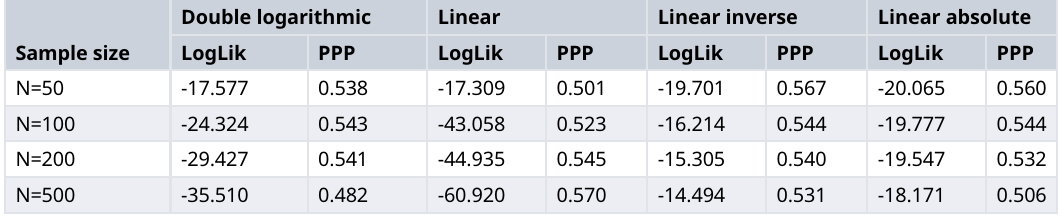
Table 5. Comparison at varying sample sizes of different heteroscedastic form.